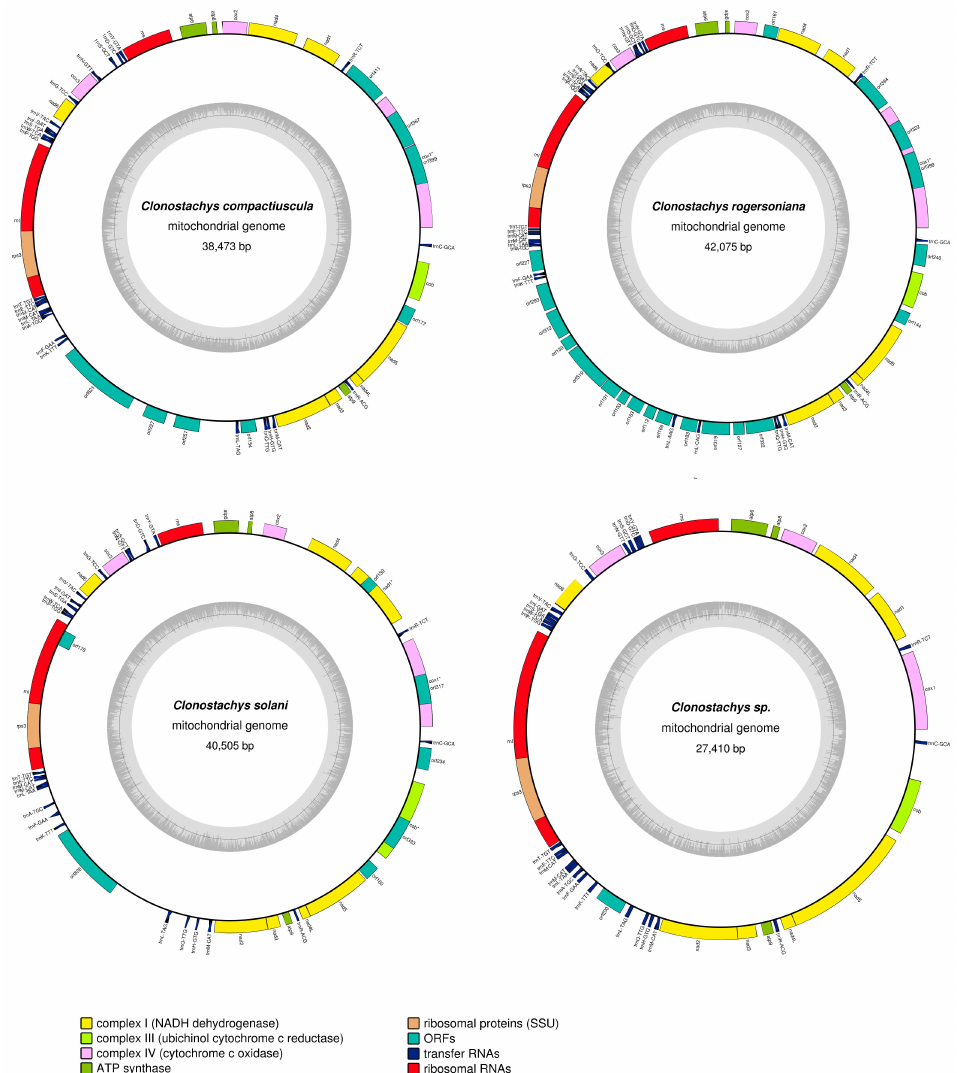
Figure 3. Circular maps of four newly sequenced mitogenomes from different Clonostachys species. (Genes are represented by different colored blocks, as presented in the legend below the maps. Colored blocks outside of each ring indicate that the genes were on the direct strand, while colored blocks in the rings indicate that the genes were located on the reverse